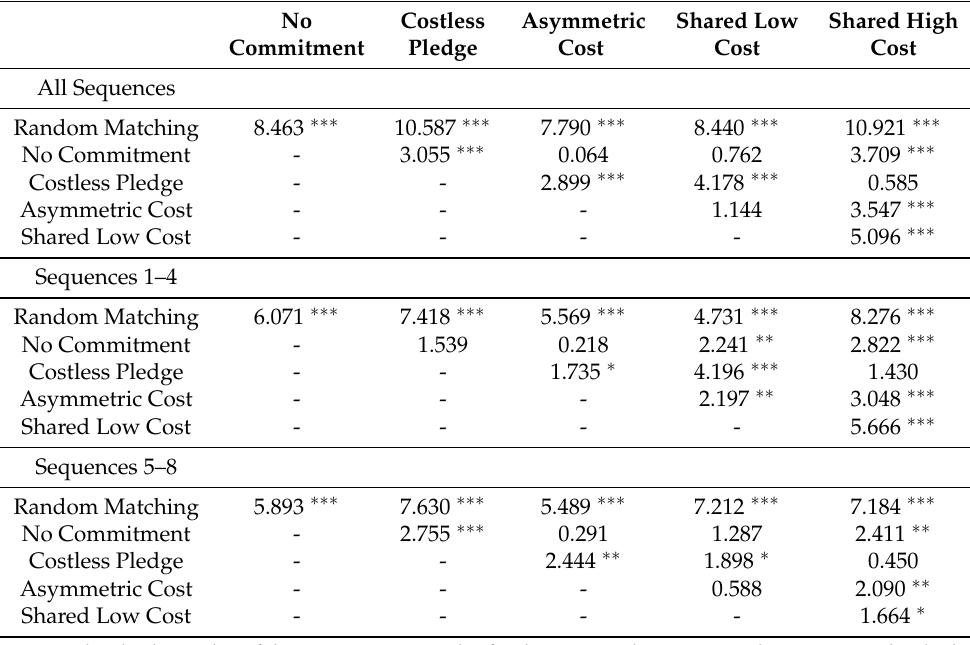
Table 2. Mann–Whitney U-test results: Overall